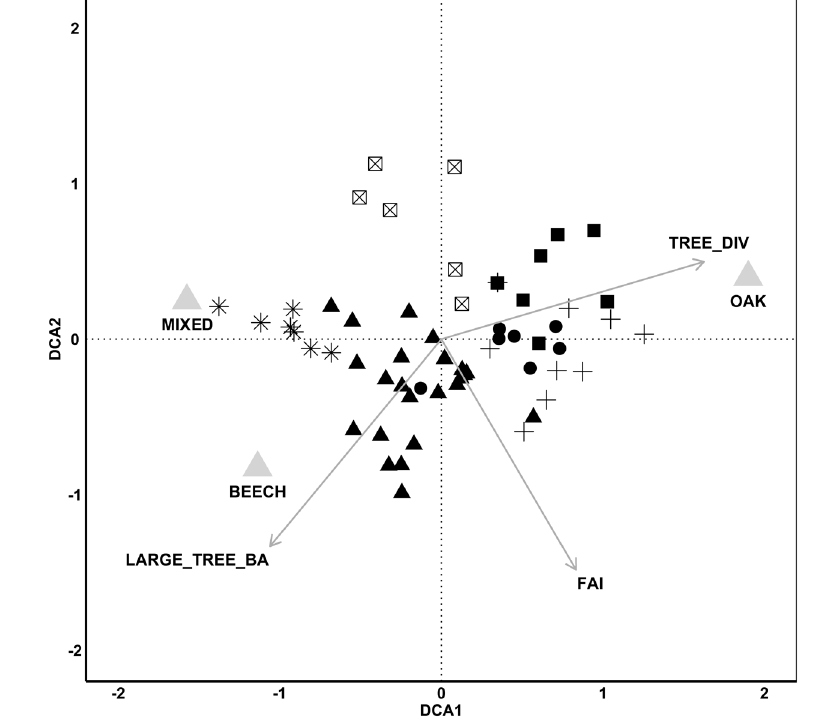
Figure 3 – DCA of the 59 plots. Only first 2 axes are presented and only significant environmental factors according to CCA are passive projected onto DCA ordinogram. Fungal assemblages are symbolized according to their classification in hierarchical clustering: black triangle = Cluster 1; star = Cluster 2; crossed-square = Cluster 3; black square = Cluster 4; black circle = Cluster 5; cross = Cluster 6. Eigenvalues: Axis 1 – 0.2617, Axis 2 – 0.1629. Length of gradient along Axis 1 –